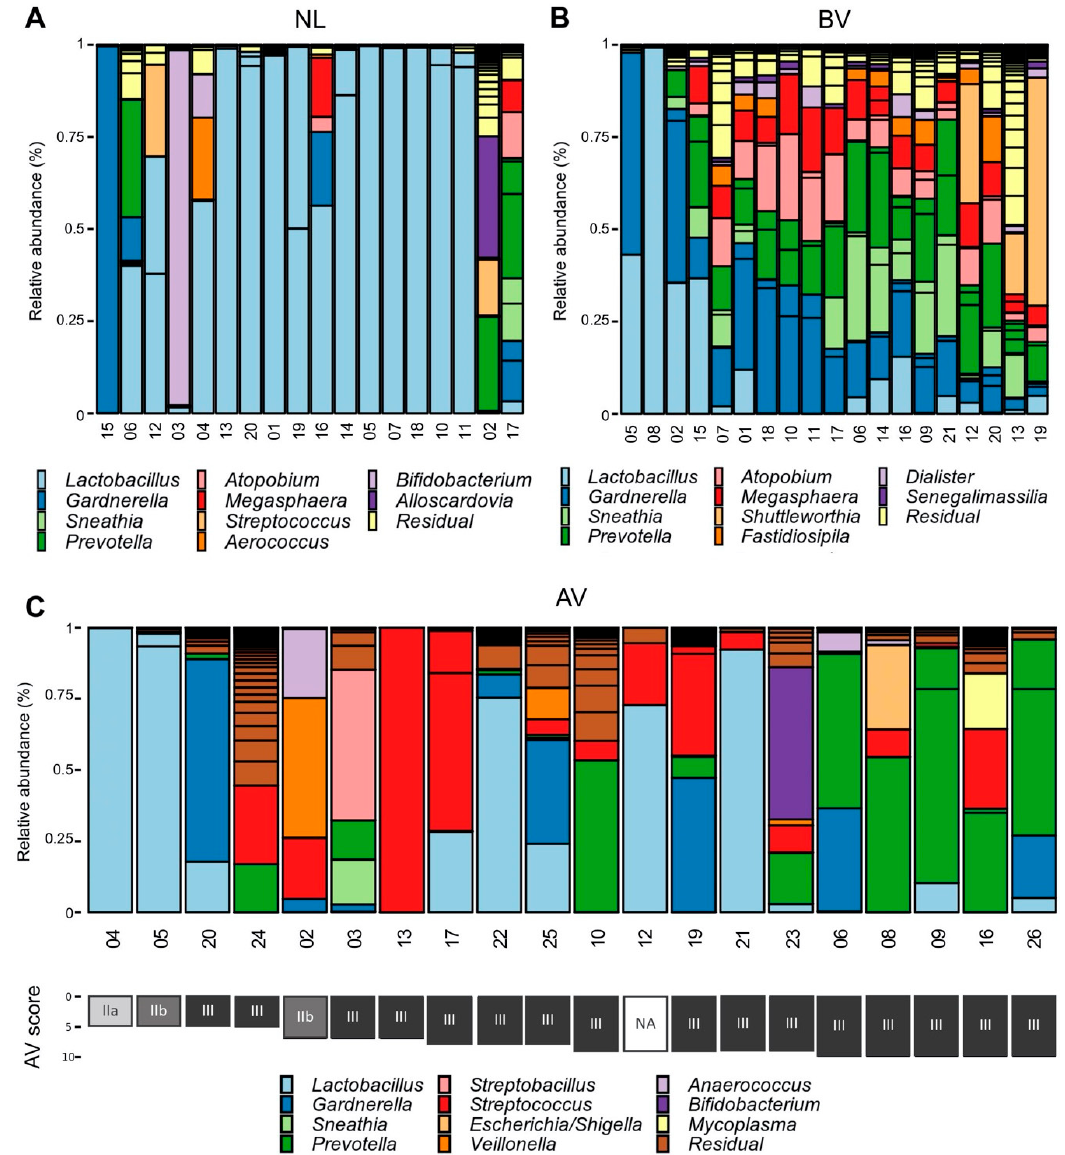
Figure 1. Bar graphs showing the taxonomic composition of the samples. Samples are categorized as ( A ) reference sample (NL), ( B ) BV, and ( C ) AV based on wet-mount microscopy (1). The abundances of the 11 most abundant genera are indicated in the bar graph with the y -axis corresponding to the relative abundance. Bars are colored according to genus or as residual in case the amplicon sequence variant (ASV) did not belong to the 11 most abundant genera. Samples are ordered according to similarity by minimizing Bray-Curtis distance between neighboring samples ( A , B ) or AV score ( C ). AV score is indicated below the sample number, colored according to lactobacillary grade (one component of composite AV score). AV: aerobic vaginitis, BV: bacterial vaginosis, NL: reference group with a lactobacillary microbiota (Lactobacillary grade I, no signs of AV or BV) according to microscopy.